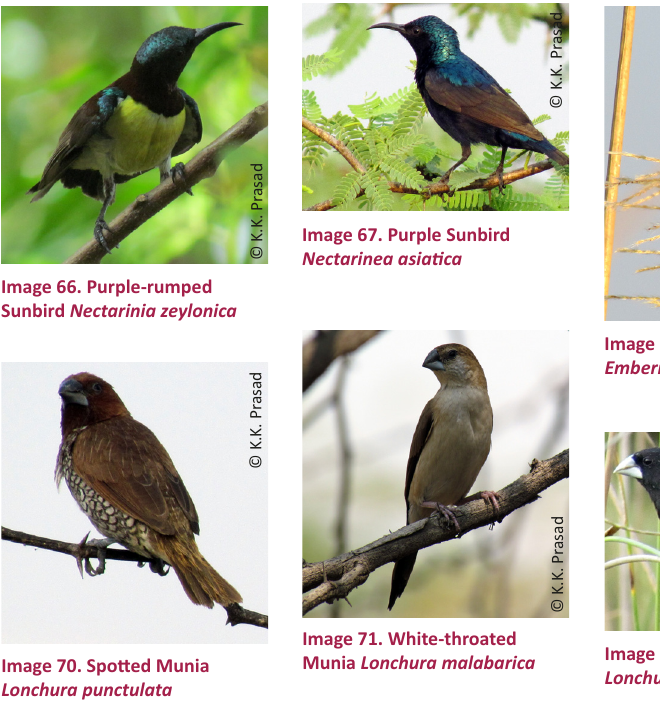
Image 73. Red Munia Amandava amandava